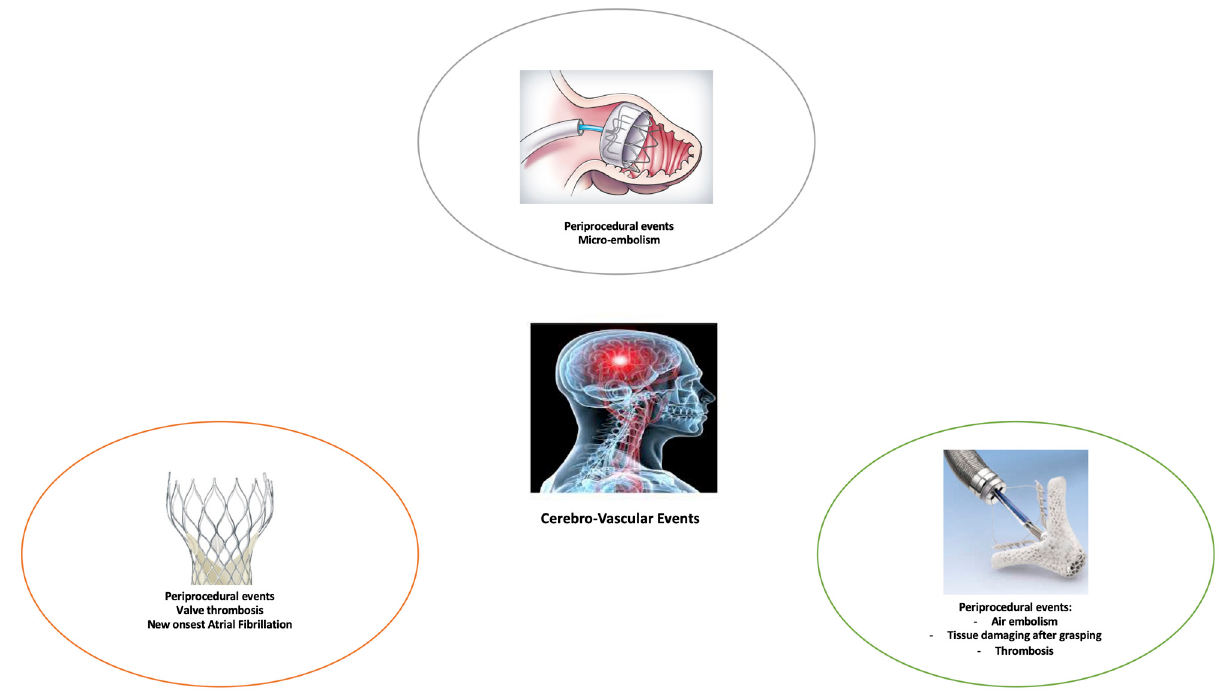
Figure 1. Mechanisms of cerebral ischemia in percutaneous non-coronary intervention procedures: transcatheter aortic valve implantation (TAVI) (orange); MitraClip (green); Left atrial appendage occlusion (grey).